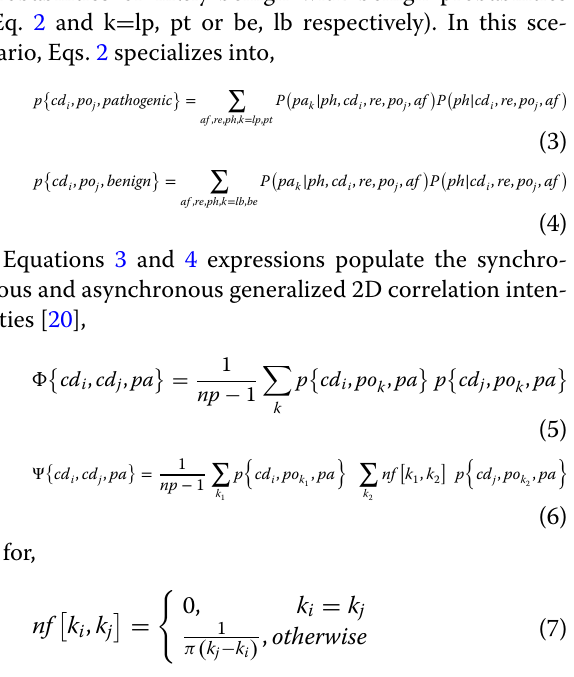
Φ in Eq. 5 gives synchronous, and Ψ in Eq. 6 asyn- chronous, 2D correlation intensities for np the number of populations represented by po , and pa either patho- genic or benign. The 2D synchronous intensity map will identify domain pairs whose SNV probabilities correlate or anti-correlate for identical populations while the 2D asynchronous intensity map identifies the leading and lagging co-domain member over populations ordered by their genetic divergence. Data obtained from calculation of protein domain SNV probability correlations is represented in 2D plots showing Φ or Ψ for the identical listing of first βmys (abbreviated M7) then MYBPC3 (C3) domains, in the order given in Supplementary Table S1 for a total of 65 domains, on both x- and y-axes. Domains are discrete entities hence the 2D plots resemble a pixelated image with grayscale representing intensity. Both intra- and inter-protein correlations are indicated with